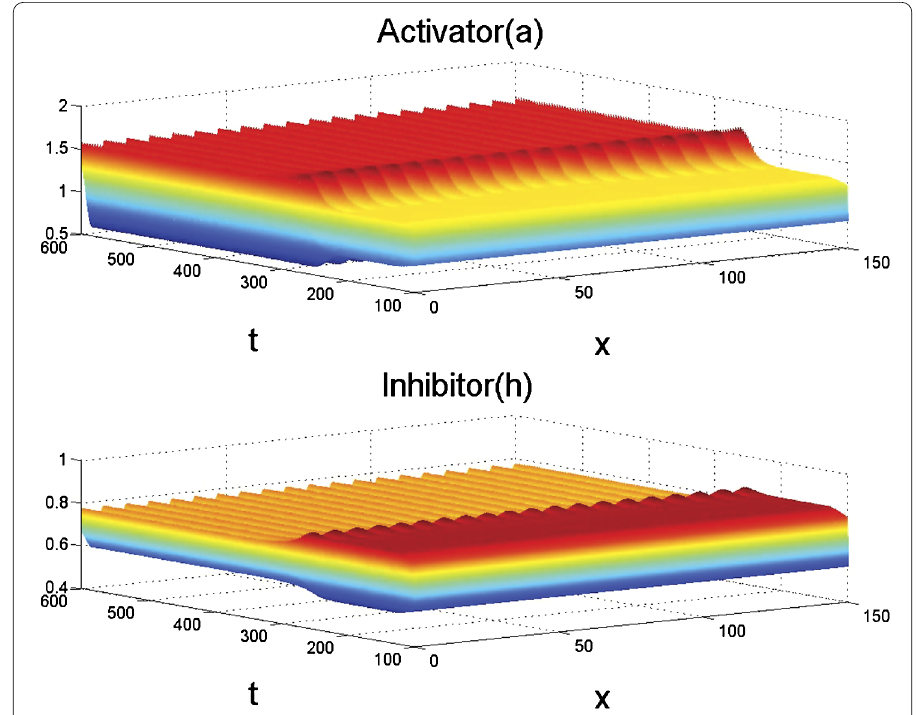
Figure 13 Turing instability of the limit cycle of (3)